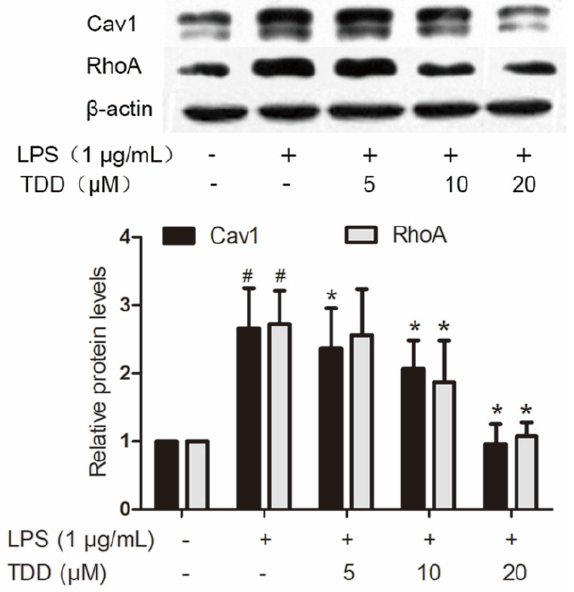
Figure 5. Effects of TDD on the expression of Cav1 and RhoA in LPS-stimulated EA.hy926 cells. EA.hy926 cells were treated with various concentrations of TDD (5, 10, and 20 µM) for 4 h, and then LPS (1 μg/mL) was added for 12 h. The data show the mean ± S.D. of three independent experiments. * p < 0.05 compared to the LPS (+) TDD (−) group. # p < 0.05 compared to the LPS (−) TDD (−) group.